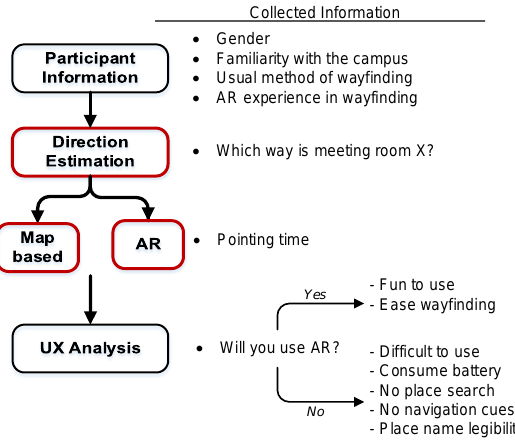
Figure 1. AR vs paper map for direction estimation – the questionnaire design